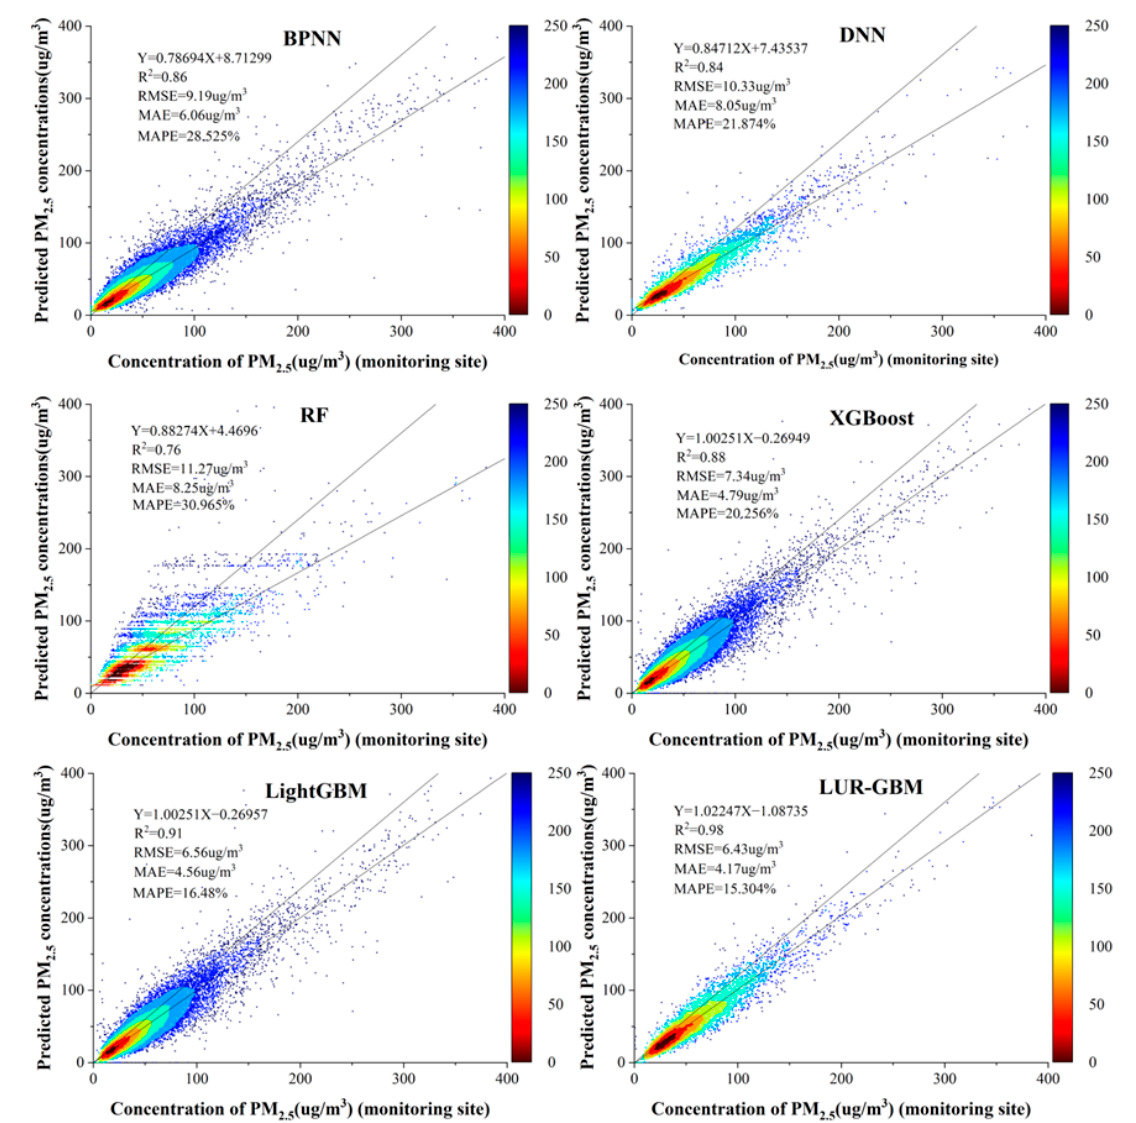
Figure 3. Six ‐ model scatter point density